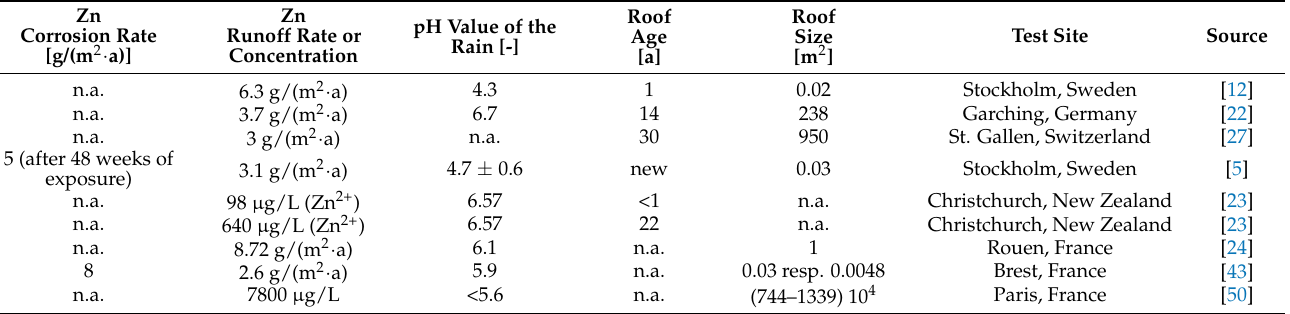
Table 1. Overview of corrosion and runoff rates (respectively concentrations in runoff) from Zn roofs under different test conditions, see respective source.